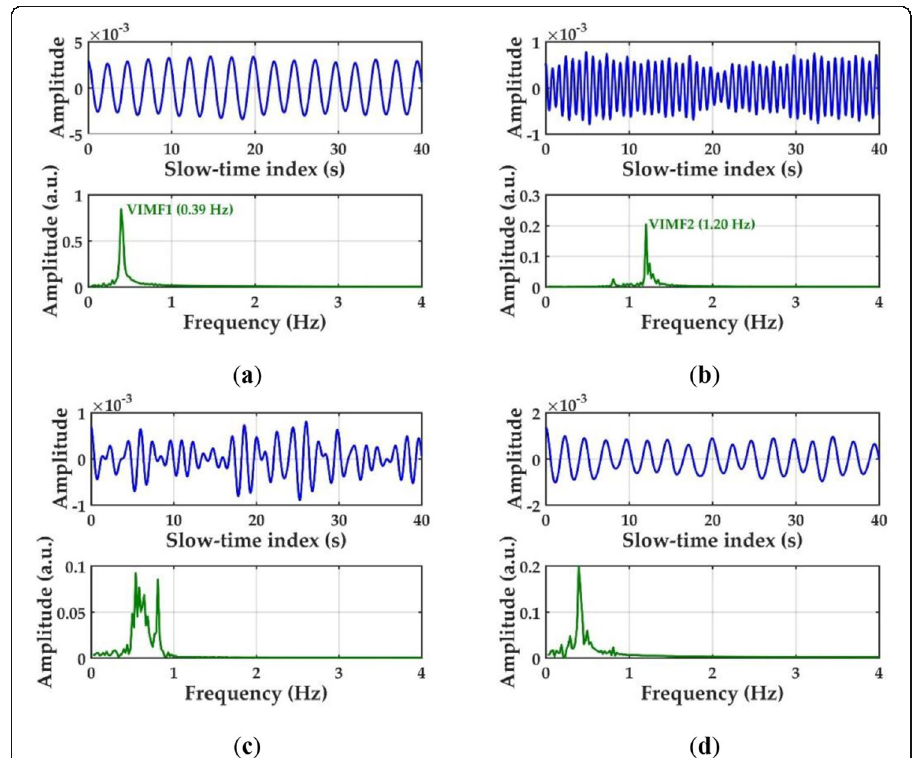
Fig. 5 Four VIMFs obtain by VMD and the corresponding spectrum of fast Fourier transform (FFT) of the signal shown in Fig. 4. a VIMF1, also regarded as the respiration. b VIMF2, also regarded as the heartbeat. c VIMF3. d VIMF4